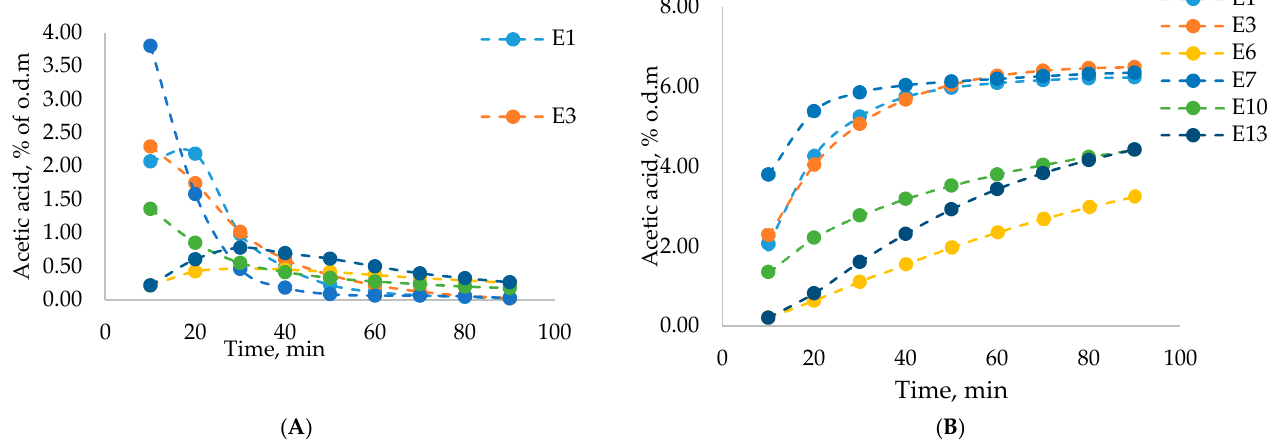
Figure 4. Dynamic acetic acid yield (% of o.d.m.) at individual time increments ( A ) and total acetic acid yield (% o.d.m.) ( B ).